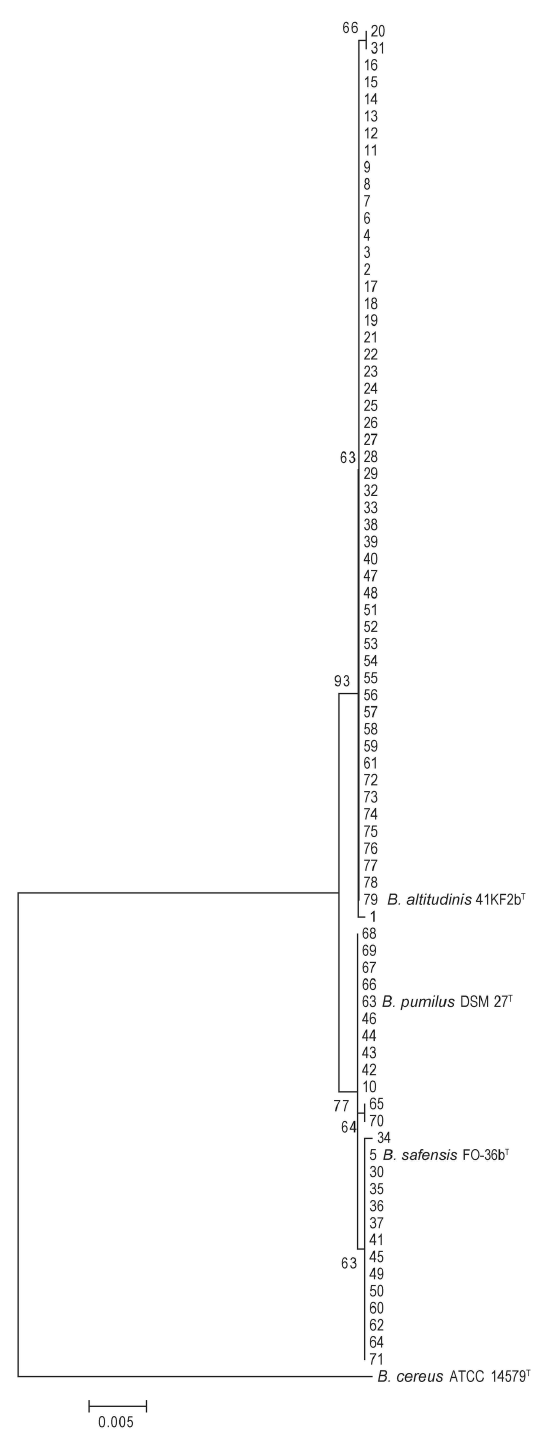
Figure 1. Phylogenetic tree based on the 16S rRNA genes of marine bacteria belonging to the B . pumilus group. The tree was constructed using the neighbor-joining method with MEGA 5.0. Bootstrap values over 50% (1000 replications) were shown at each node. Bar, % estimated substitution. B . cereus ATCC 14579 T was used as the outgroup. doi: